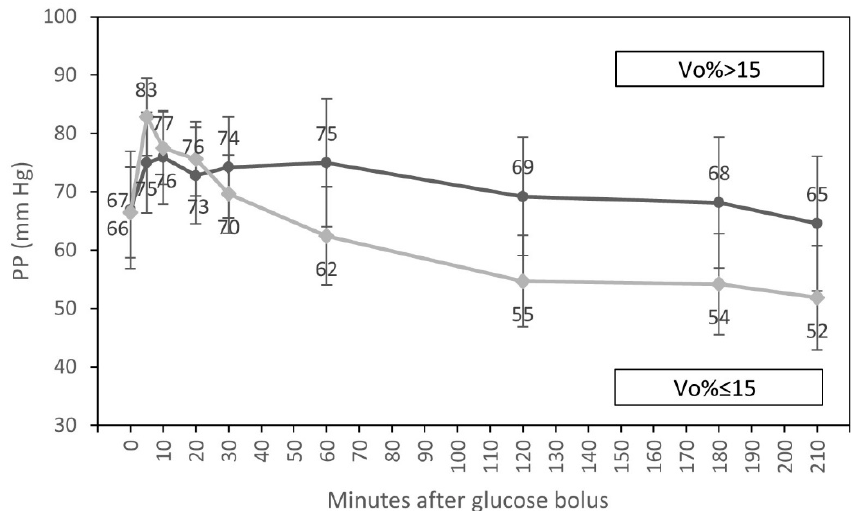
Figure 4. Course of pulse pressure (estimated marginal means, 95% CI) for groups with low (<15%) and elevated ( ≥ 15%) relative volume overload at the beginning of hemodialysis, adjusted for diabetic status and systolic blood pressure at the start of HD.